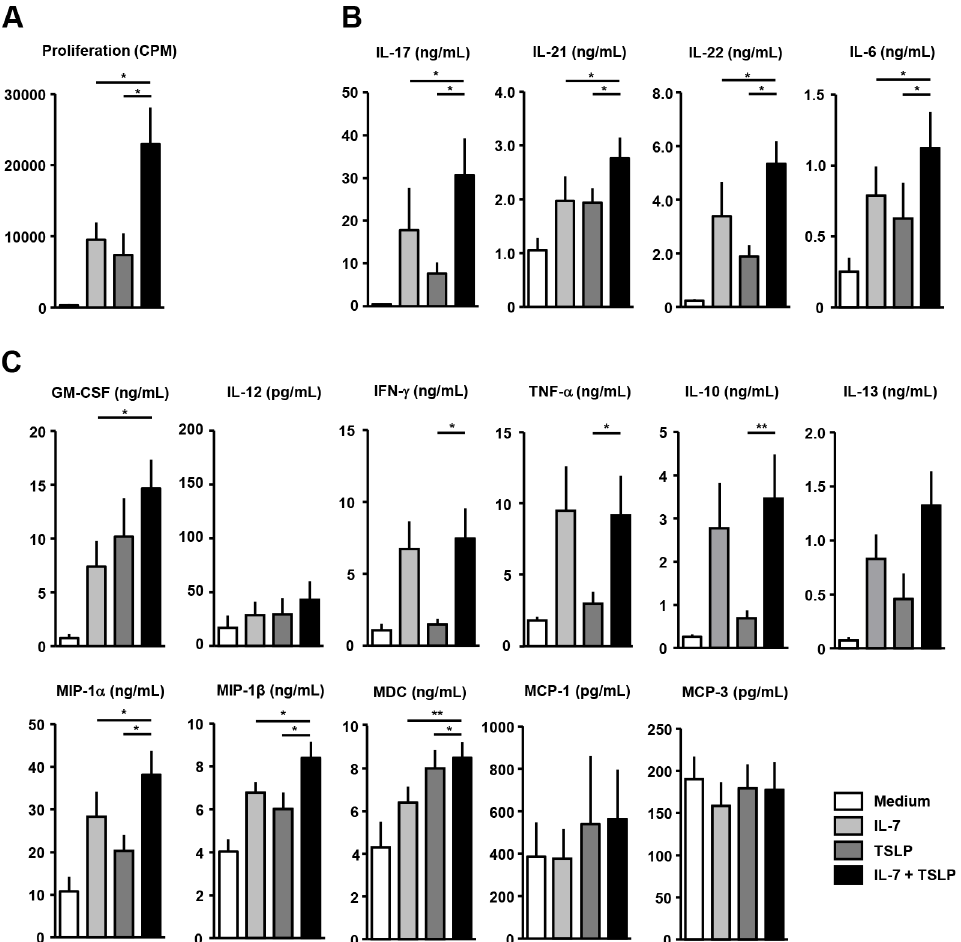
Fig 4. TSLP and IL-7 additively induce T-cell proliferation and Th17-activity in a human cDC/T-cell co-culture. Paired CD1c-expressing classical dendritic cells (cDCs) and CD4 + T-cells were isolated from rheumatoid arthritis patients. CD4 T-cells were co-cultured with cDCs for 6 days in the presence